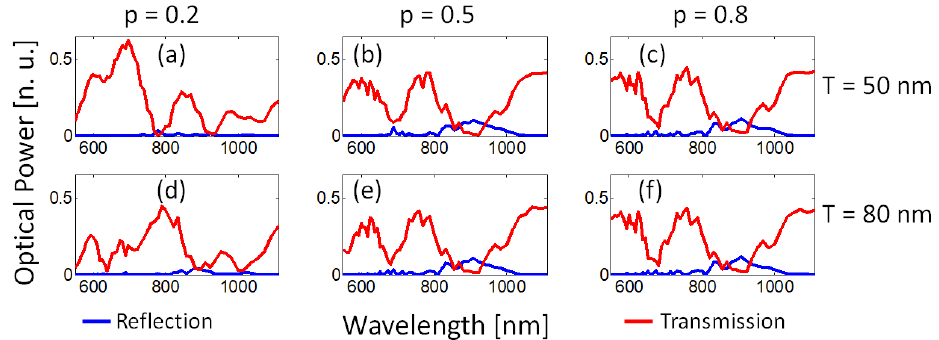
Figure 7. Dependence of broad-band deeps as a function of the period ( T ) and filling fraction ( p ) for a fixed number of layers ( N = 8 layers). ( a – c ) T = 50 nm, and ( d – f ) T = 80 nm, for p = [ 0.2,0.5,0.8 ] , respectively. For p = 0.2 ( a , d ), transmission (red solid) and reflection (blue dashed) spectra are modified, while for p = 0.5 and p = 0.8, they remain almost